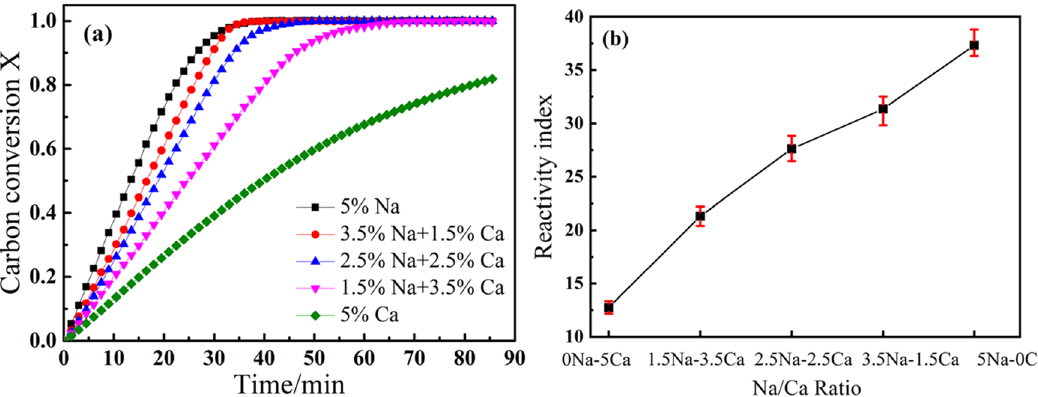
Figure 7: E ff ect of Na/Ca composite fl ux agent content on the reactivity of ZJX char: ( a ) gasi fi cation rate and ( b ) gasi fi cation reactivity index.